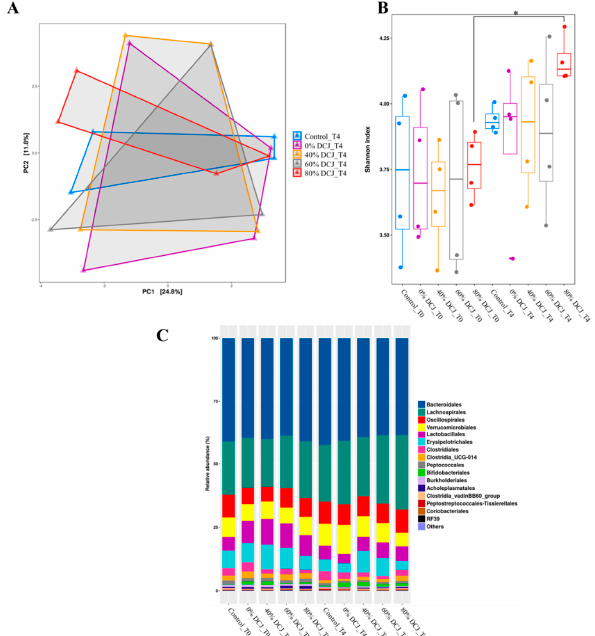
Figure 3. Impact of the administration of the different DCJs on ( A ) the global structure of the microbiota after 4 weeks of treatment, reflected by the principal coordinate analysis (PcoA) on the unweighted UniFrac (Unique Fraction) distance matrix. ( B ) The alpha-diversity of the gut microbiota before (T0) and after the end (T4) of the experiment, as measured with the Shannon index. ( C ) Relative abundance of taxa at the genus level.